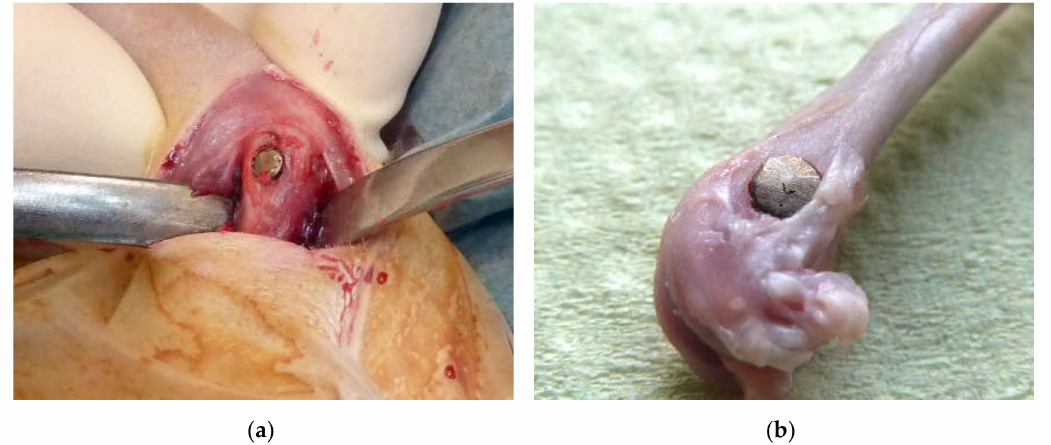
Figure 14. The implant sits press fit inside the defect during the surgery ( a ). An explanted femur shows the position of the implant ( b